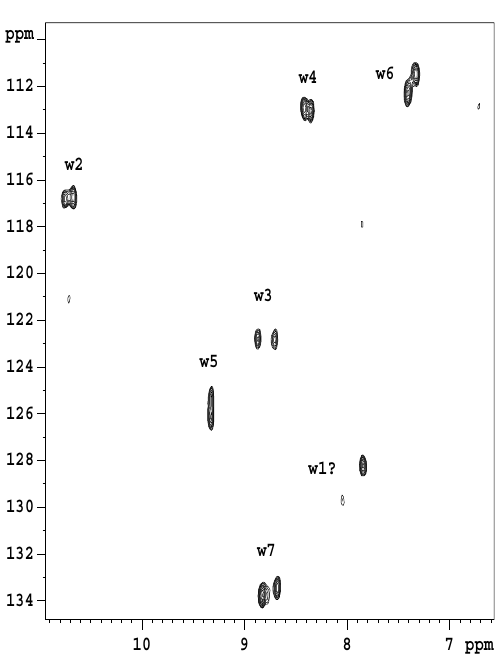
Figure 3. 15 N-T 2 filtered HSQC experiment displays exclusively the tetramer signals, since the faster spin–spin relaxation destroys the signals of the octamer. Labels w stand for amide NH groups; numbers are according to sequential position. Signals are doubled because of the asymmetry of the dimeric building blocks. One of the w1 signals is too weak, and therefore is labelled with a question mark.